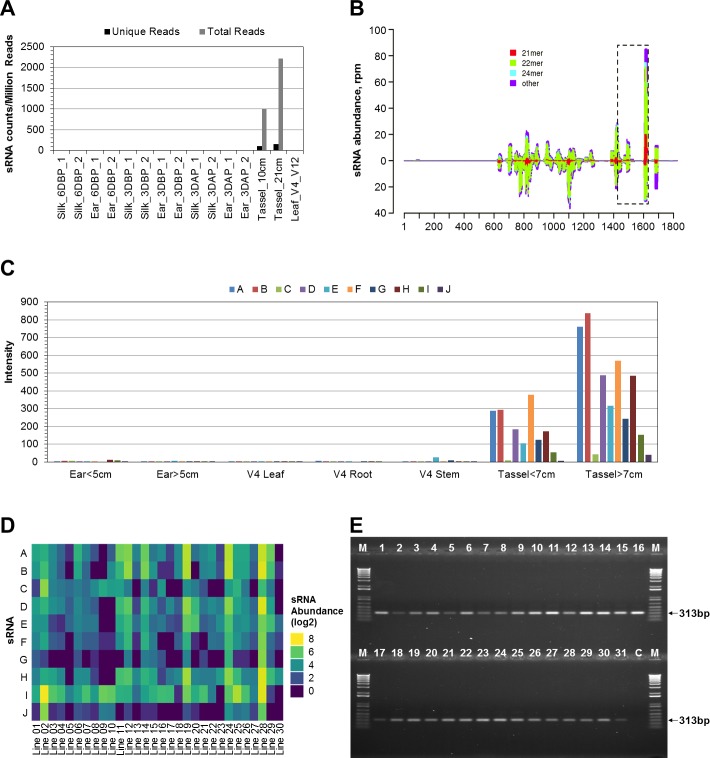
Identification of mts-siRNAs and selection of transgenic target.(A) Abundance of putative EU974548 targeting mts-siRNAs in small RNA libraries derived from 15 tissues as indicated. Unique reads do not include redundant reads. Total reads count both unique and redundant reads. DBP: days before pollination; DAP: days after pollination. (B) Distribution of mts-siRNAs on the EU974548 cDNA sequence (1826 bp long). mts-siRNAs sharing the same as or complementary to the cDNA strand are shown above and below the zero line, respectively. The vertical axis indicates normalized relative expression levels of mts-siRNAs. The horizontal axis shows the nucleotide position from the beginning of the cDNA. mts-siRNA lengths are indicated by different colors. The boxed area, rich in mts-siRNA recognition sites, was selected as a transgenic target and placed after the coding region of the CP4 EPSPS (S2 Fig). (C) Tassel specificity of representative mts-siRNAs targeting the boxed area. Abundances of mts-siRNAs A to J (S2 Table.) in maize tissues of the germplasm into which the transgene was transformed were measured by microarray. The vertical axis shows signal intensity. (D) Presence of the mts-siRNAs A to J in V8 tassels of thirty additional representative maize germplasms commonly cultivated in North America. Graphic representation was based on microarray signal intensities. (E) Conservation of one endogenous gene (Zm00001d036860) with sequence homology to the mts-siRNAs. Lane M: 1kb Plus DNA size marker (Thermo Fisher Scientific). Lanes 1 through 31: PCR products from genomic DNA obtained from leaves of the germplasm into which the transgene was transformed and thirty additional representative maize germplasms commonly cultivated in North America. Lane C: no templates control.